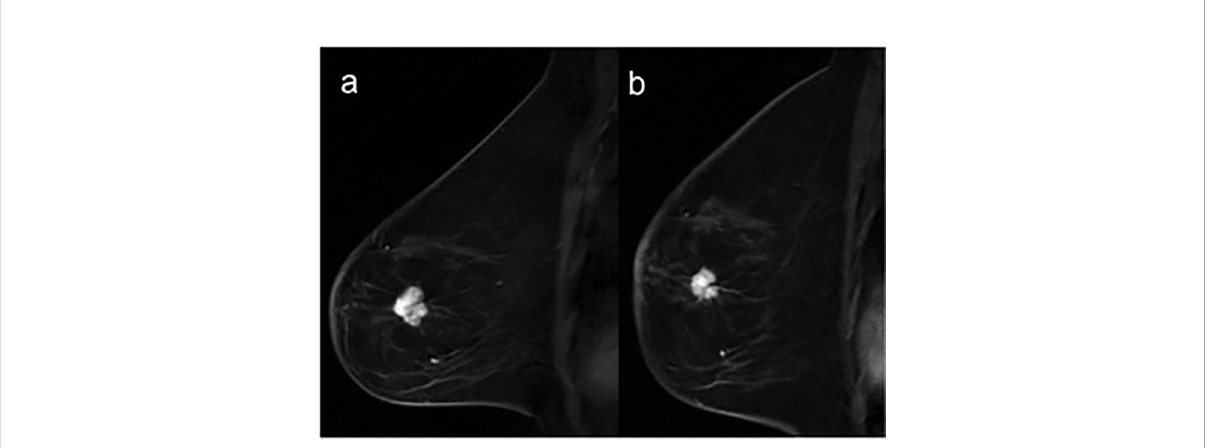
FIGURE 3 Breast MRI of a 57-year-old sarcopenic woman (SMI = 34.3 cm 2 /m 2 ; SMI < 40 cm 2 /m 2 = sarcopenia) with invasive ductal carcinoma of the left breast. Sagittal post-contrast T1-weighted images, before (A) and after (B) 6 months of treatment shows a substantial stability in the size of the lesion located in the lower-outer quadrant of the left